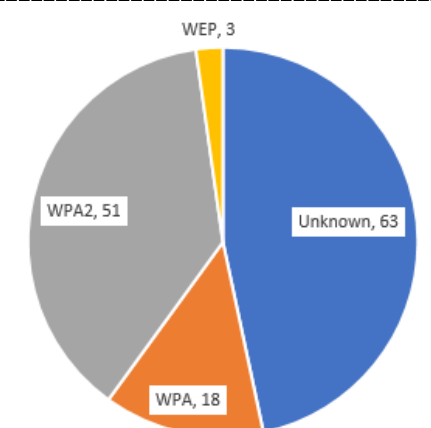
Fig. 1. The answers of 135 respondents to the question “Please pick the encryption method of your private W-Fi network”. Amount of times each answer has been picked is given after the answer.